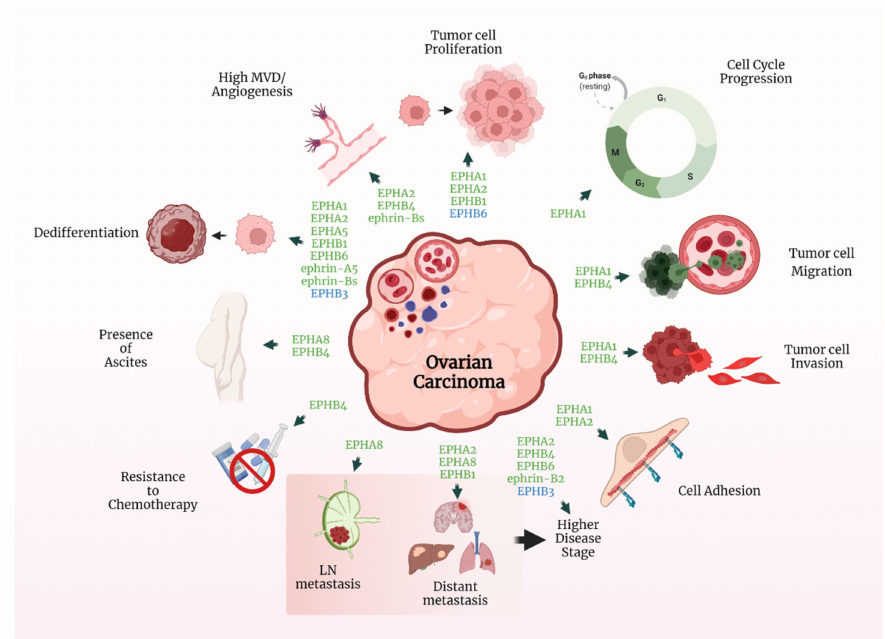
Figure 2. Key roles of the EPH/ephrin system in OC pathogenesis. Green font: EPHs/ephrins that promote each described process. Blue font: EPHs/ephrins that inhibit the specific action. Created with